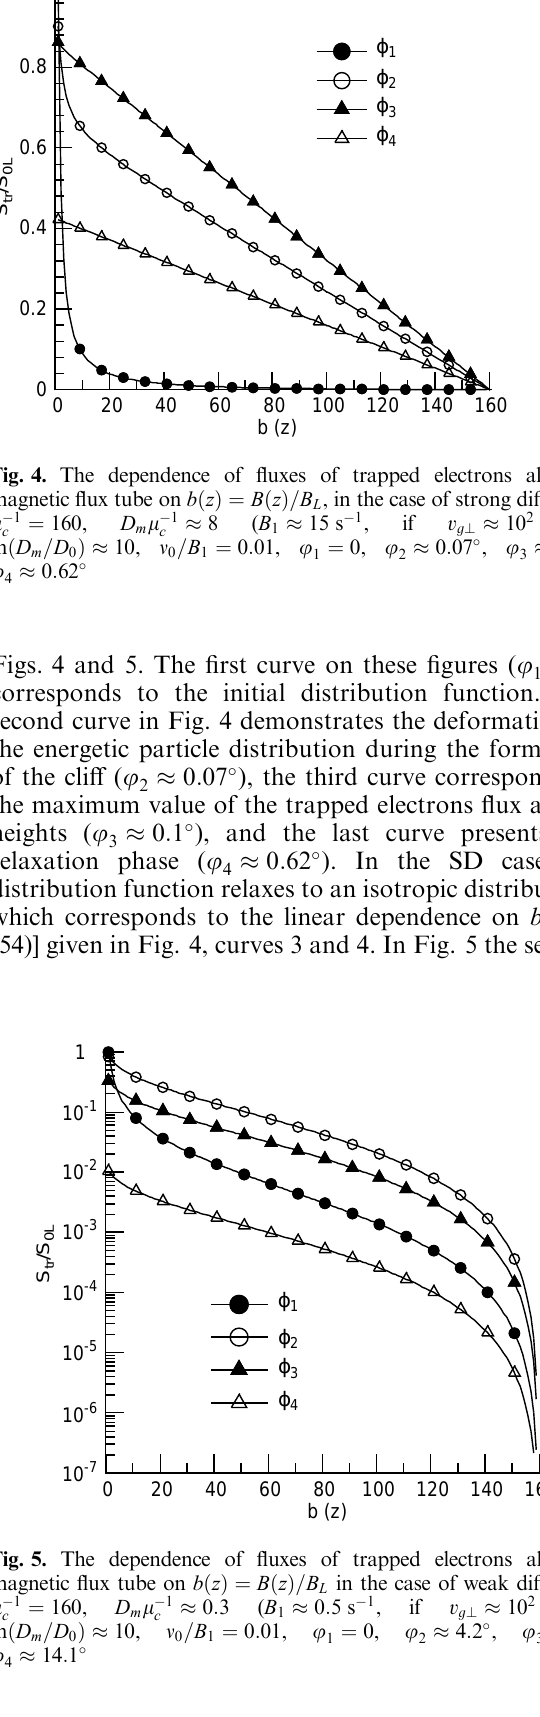
Fig. 5. The dependence of fluxes of trapped electrons along a magnetic flux tube on b z (cid:133) (cid:134) (cid:136) B z (cid:133) (cid:134) = B L in the case of weak